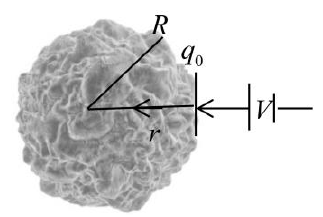
Figure 1. A tumor is subjected to a thermoelectrical source with voltage V.